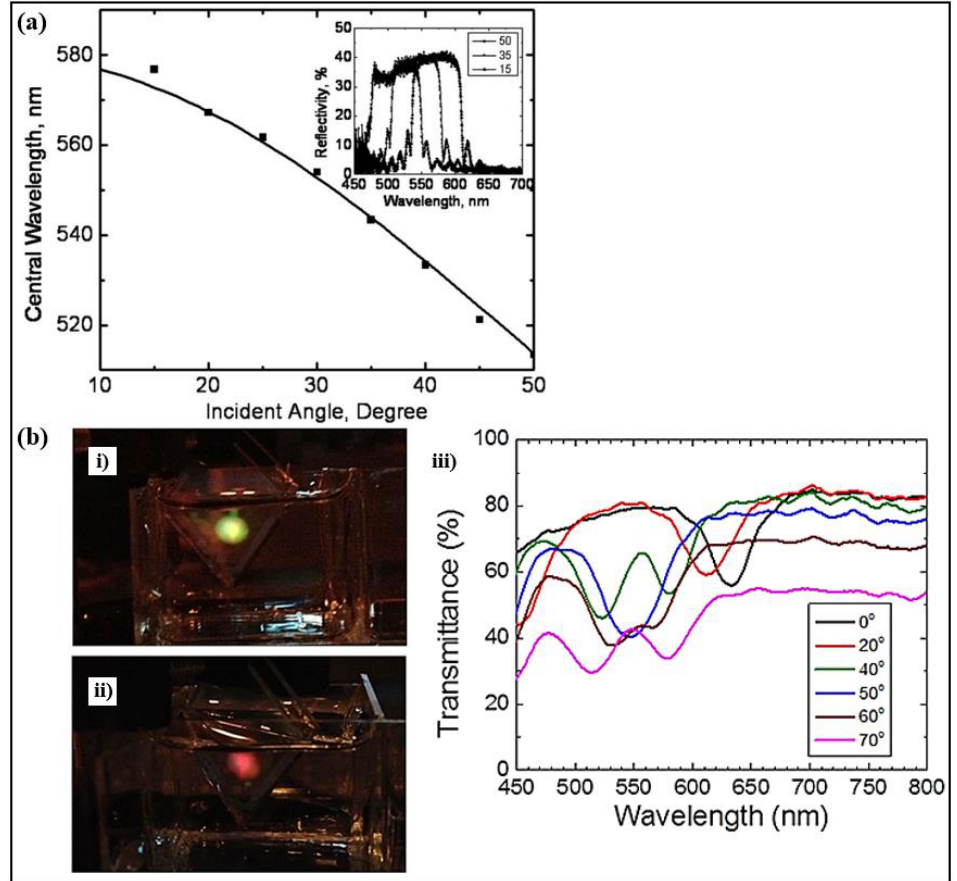
Figure 7. ( a ) Central wavelength of tunable filter versus incident angle. Reproduced with permis- sion from Ref. [91]. Copyright 2011 Optical Society of America. ( b ) i) First-order and ii) second-order reflection of the BPLC cell. iii) Transmission spectra of polymer-stabilized BPLC. Reproduced with permission from Ref. [88]. Copyright 2013